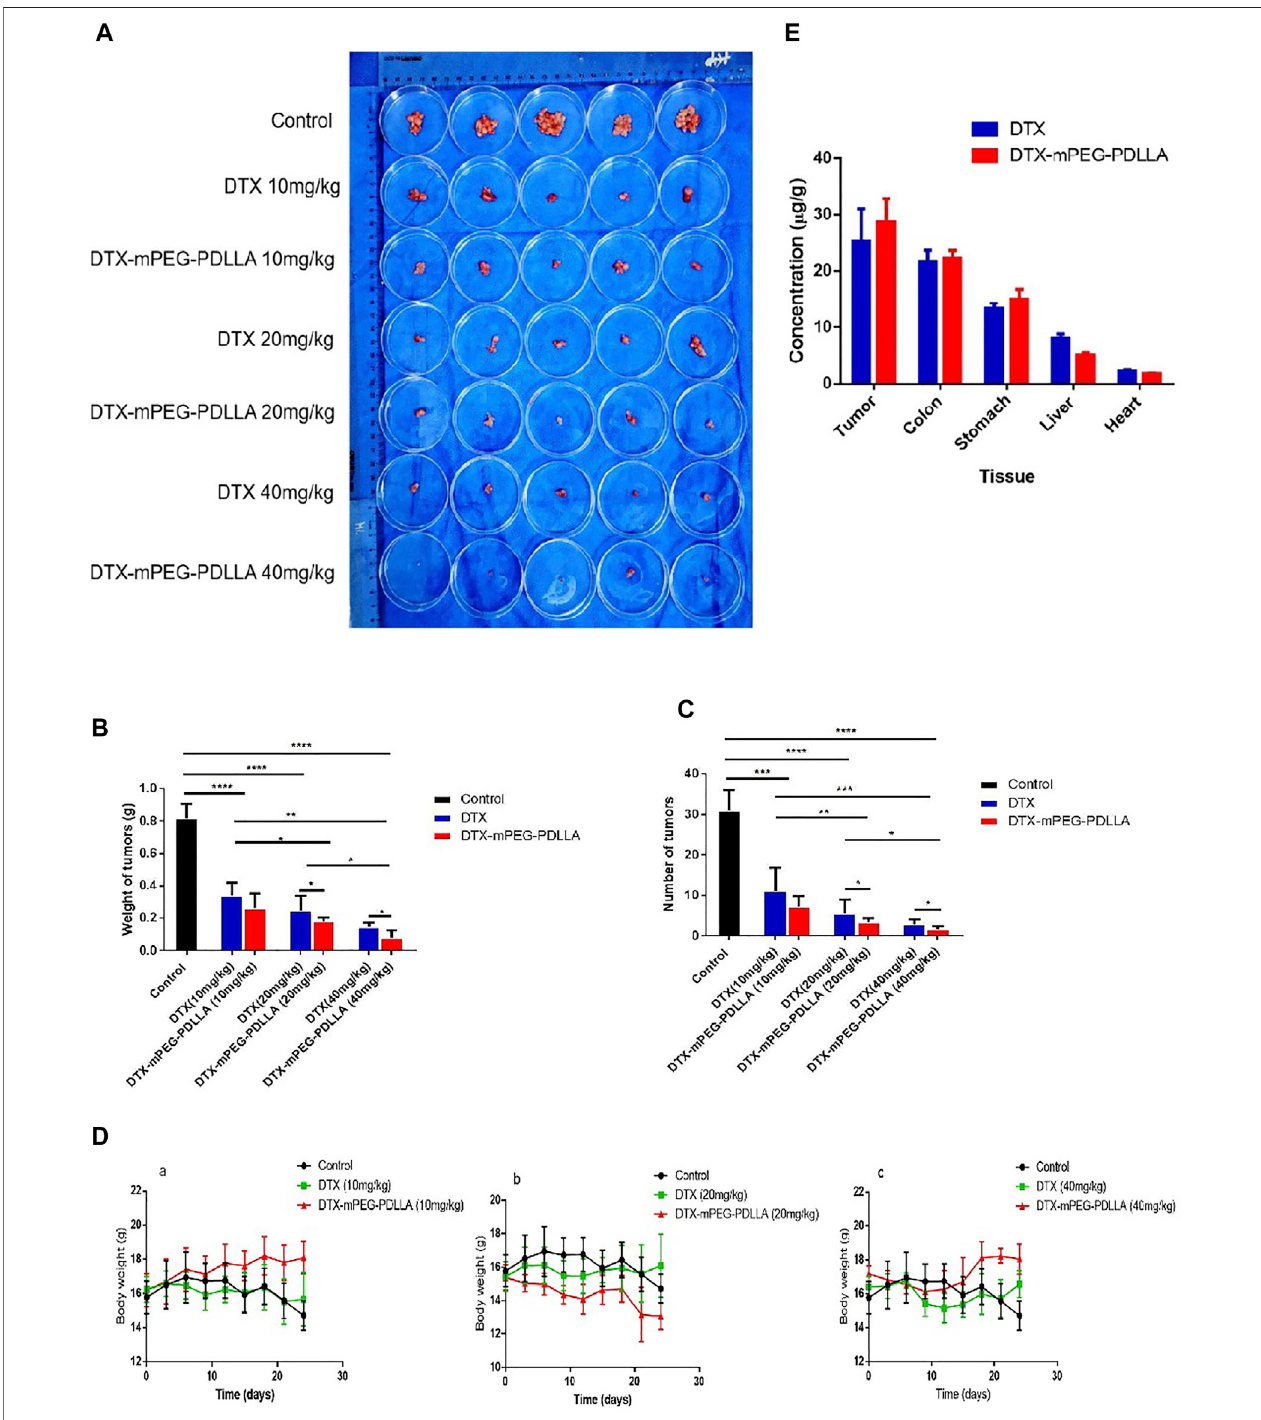
FIGURE6| AntitumoreffectandtissuedistributionofDTX-mPEG-PDLLAmicellesbyIPadministrationinovariancancerperitonealmetastasis. (A) Photographsof peritoneal cavity tumors in each group on day 24 after IP administration. (B) Analysis of tumor nodules weight. (C) Numbers of tumor nodules. (D) Changes in body weightofmiceinthe10 mg/kg(a),20 mg/kggroups(b),40 mg/kggroups(c),andthecontrolgroup,whichwasinjectedwithNSbyIPadministration. (E) Comparisonof DTX and DTX-mPEG-PDLLA in tissues and tumors 1 h by IP administration at 10 mg/kg dosage. * p < 0.05, ** p < 0.01, *** p < 0.001, and **** p < 0.0001.